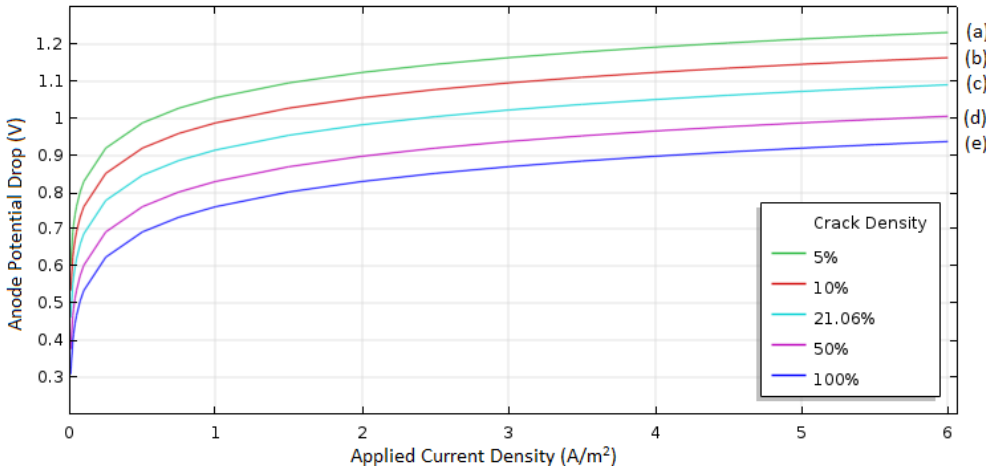
Figure 7. Potential drop between the Al anode and the anodic oxide film surface at crack fractions of a) 5%, b) 10%, c) 21.06%, d) 50%, and e)